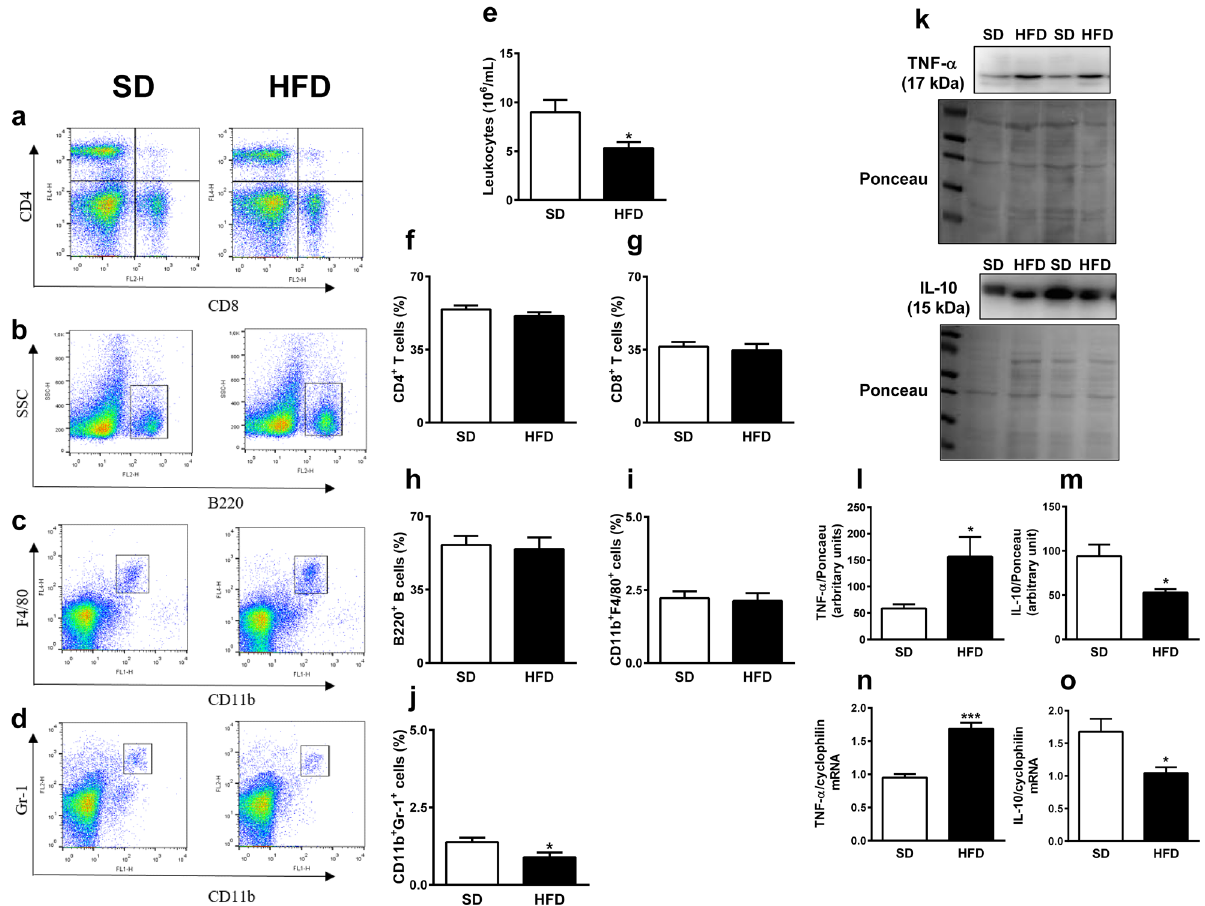
Figure 5. Mice fed a high-fat diet (HFD) presented leukopenia and increase in inflammatory markers in the spleen. ( a – d ) Representative dot plots of flow cytometry, ( e ) number of total leukocytes and populations of ( f ) CD4 + and ( g ) CD8 + T lymphocytes (percentage of CD3 + cells), ( h ) B220 + B lymphocytes, ( i ) CD11b + F4/80 + macrophages and ( j ) CD11b + Gr-1 + granulocytes (percentage of total cells) in the spleen of mice fed standard diet (SD) or HFD. Results from two different experiments (n = 5 to 8 per group). ( k – m ) Cropped blots, membranes stained with Ponceau and densitometry analysis for TNF-α and IL-10 in spleen of mice fed SD and HFD. (n = 4 per group). Full-length blots are shown in Supplementary Fig. S2. ( n – o ) TNF-α and IL-10 mRNA levels in spleen of mice fed SD and HFD. (n = 5 per group). Data were expressed as mean ± SEM. Unpaired t -test: * P < 0.05, HFD versus